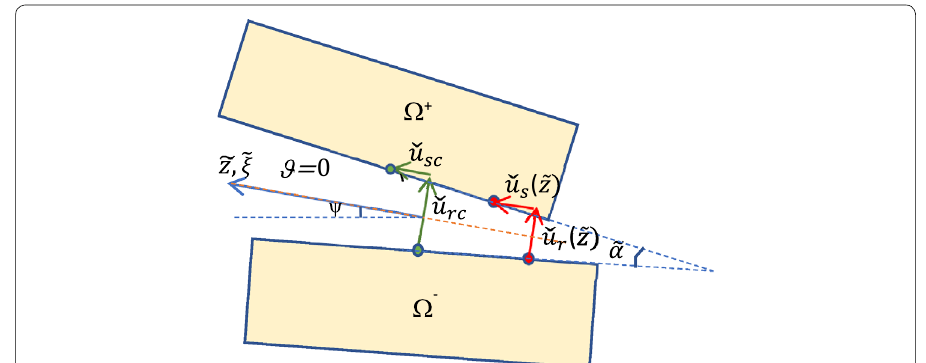
Fig. 1 Inelastic relative displacement of Ω k + with respect to Ω k − in the strong discontinuity element